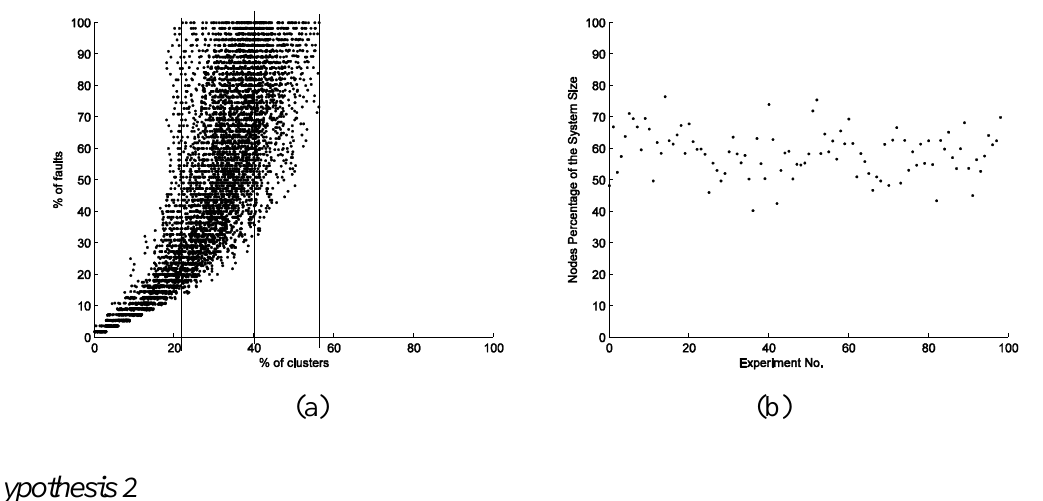
Figure 2. (a) Percentage of clusters versus percentage of faults. Each black dot denotes the correlations between the number of fault nodes and the number of clusters. (b) Nodes percentage of the system size. Each black dot denotes the proportion of the nodes which belong to those clusters that contain 80% fault nodes, to the total nodes of the wireless sensor network in one